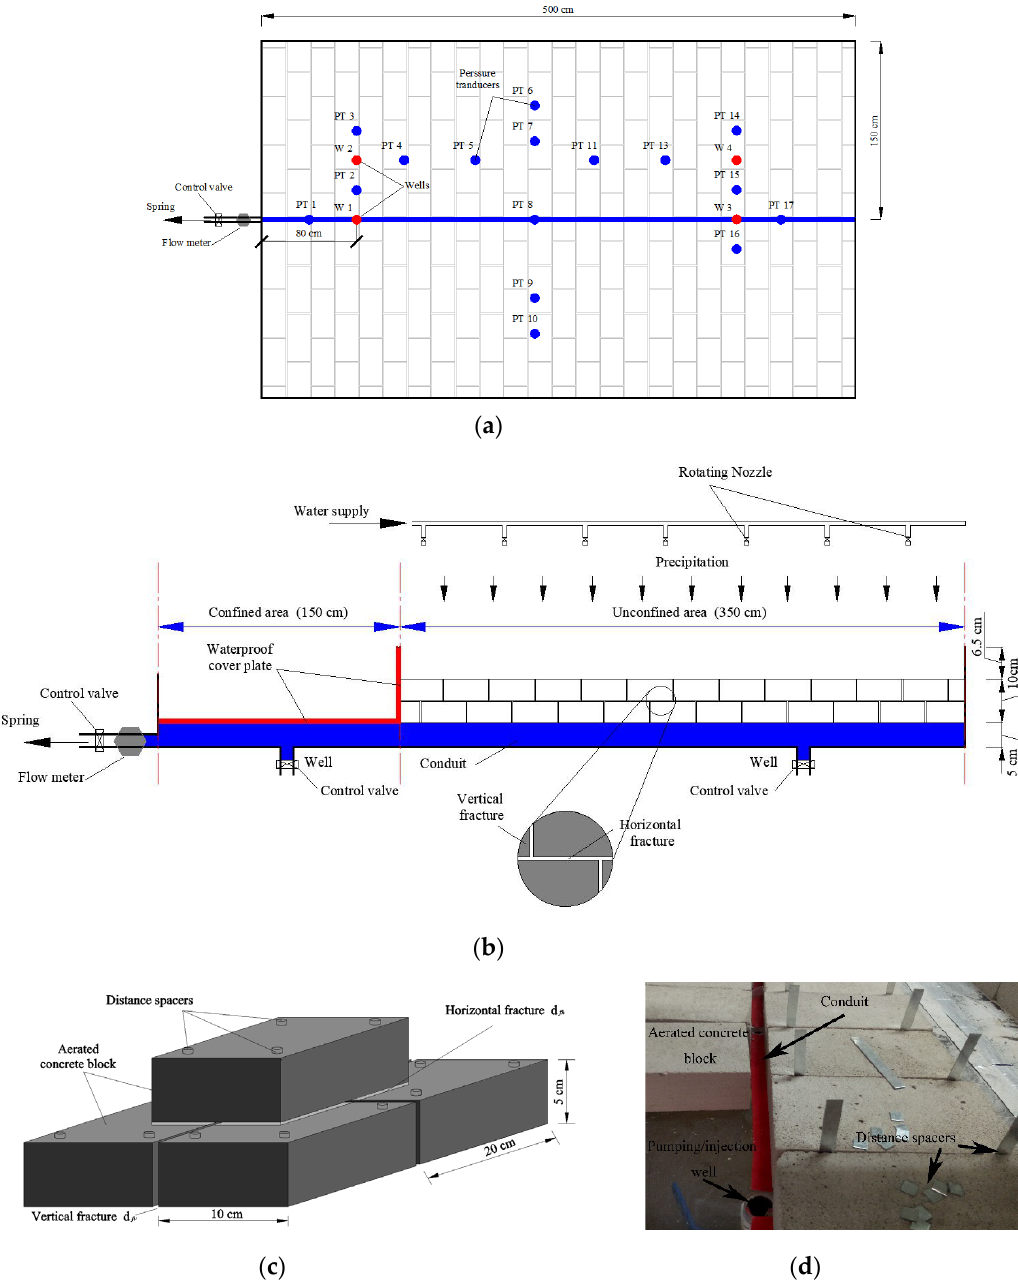
Figure 3. Laboratory setup and details of the construction of fissures and conduit medium. ( a ) Ichnography of the physical model, distribution of wells, and pressure transducers. ( b ) Cross-section of the physical model with descriptions of the structure of the simulated aquifer. ( c ) Fissures medium construction. ( d ) Photo of fissure and conduit medium construction.